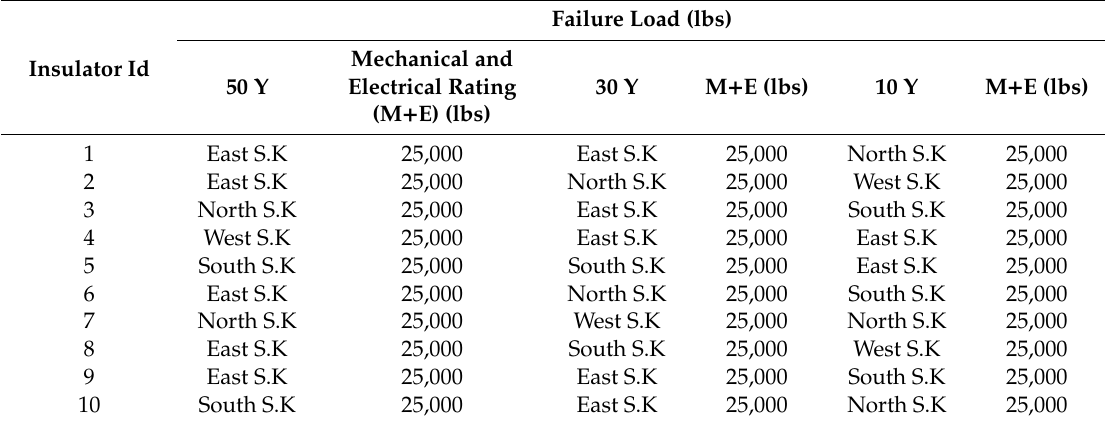
Table 1. Specifications of porcelain insulators under